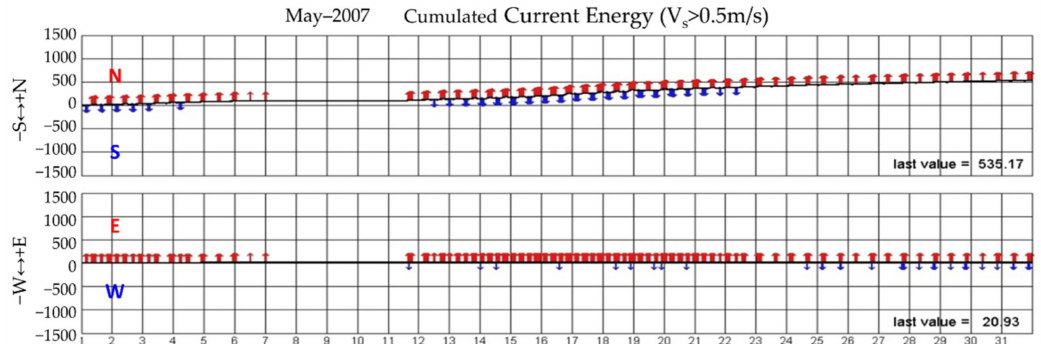
Figure 15. Cumulated energy for velocity > 0.5